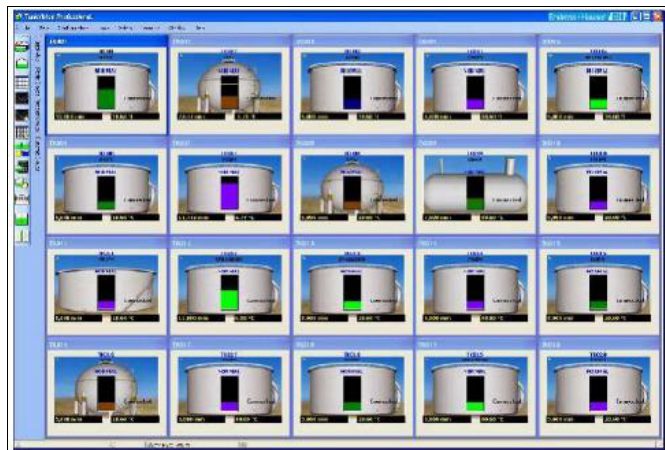
Figura 4: Una de las pantallas de la aplicación supervisoria TankVision Professional, desarrollada para el sistema de almacenamiento de